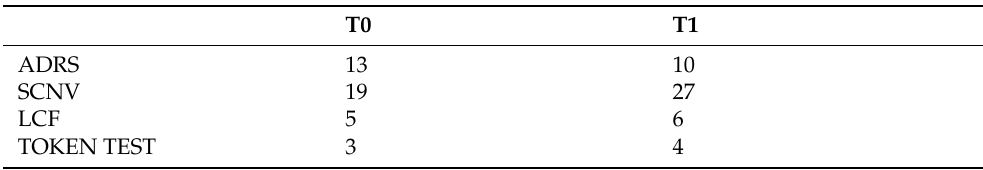
Table 2. Assessment of Neuropsychological clinical